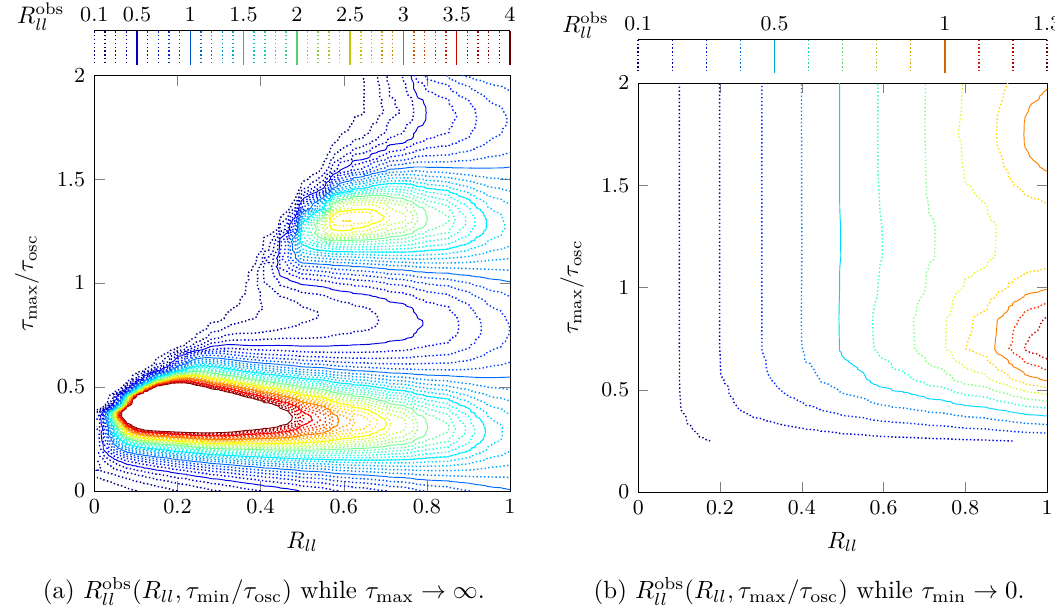
Figure 15 . MC simulation of the reliability of the observation of R ll when considering finite detectors. The variables are the same as in figure 5 . The plot in panel (a) agrees only in the lower right half with the theoretical results figure 5 (a), since for large cut values and small R ll no events are generated. The plot in panel (b) reproduces the analytic behaviour from figure 5